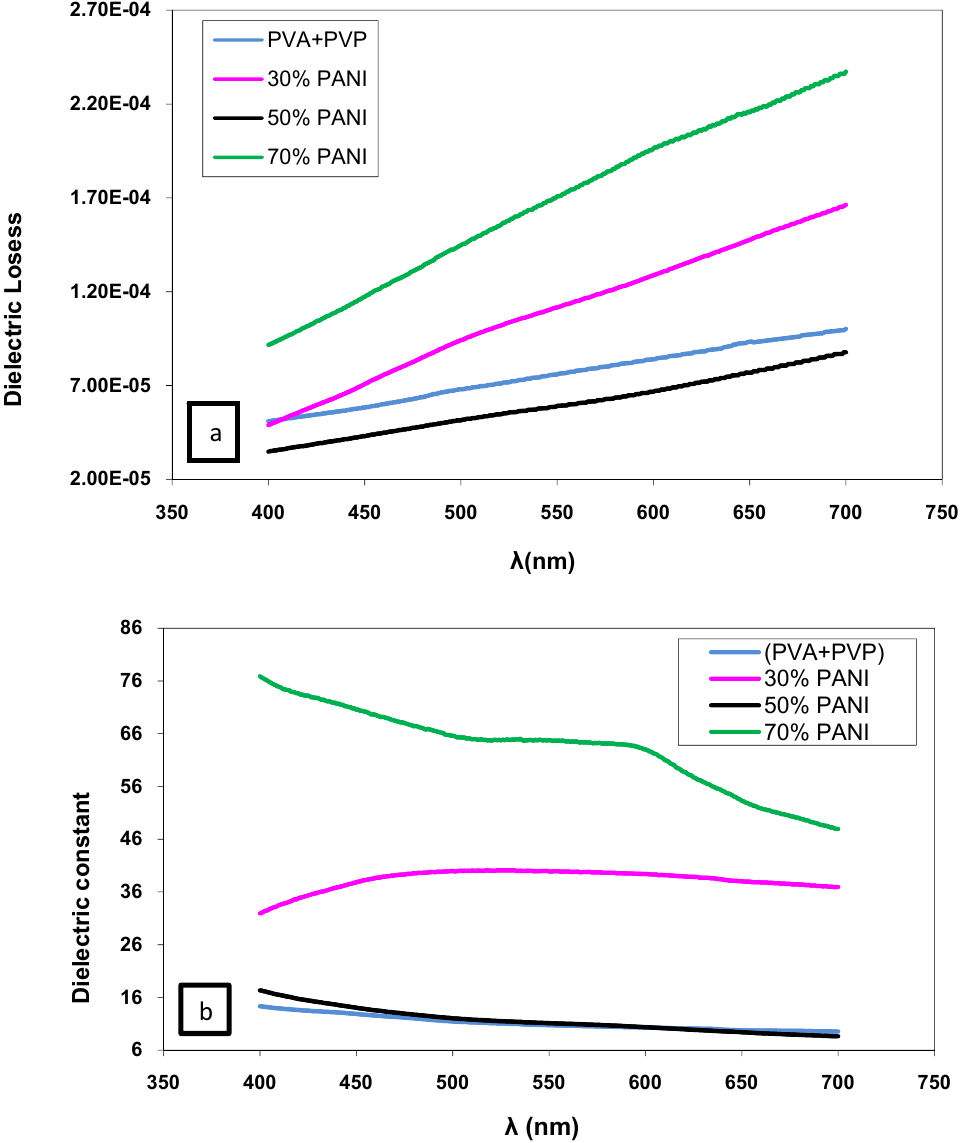
Fig. 7: Dielectric constant, (a) dielectric loss (b)dielectric constant vs. wave length (nm) for (PVA-PVP) +PANI blends